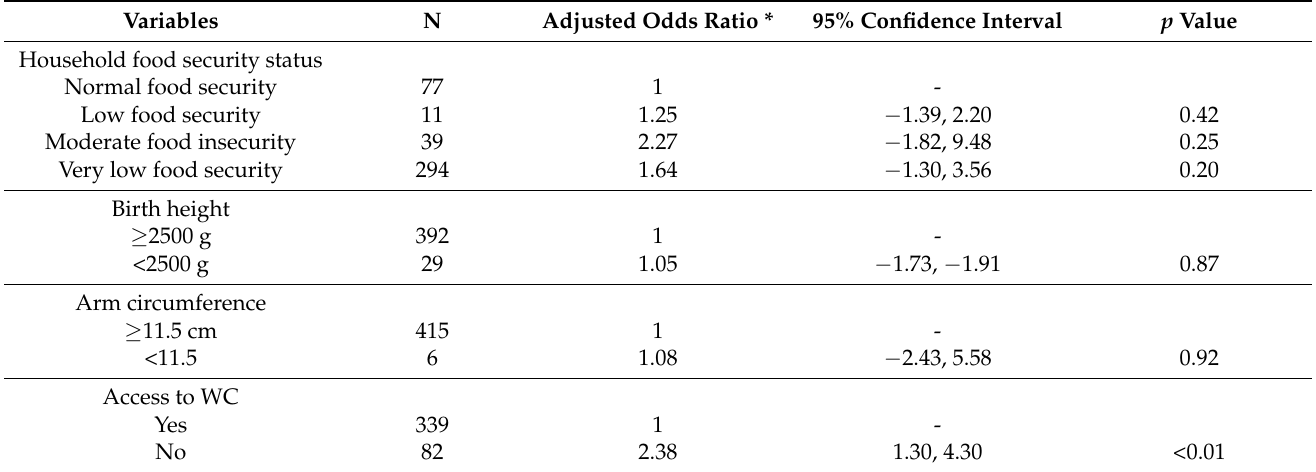
Table 6. Odds ratio of weight for height based on the ordinal logistic regression